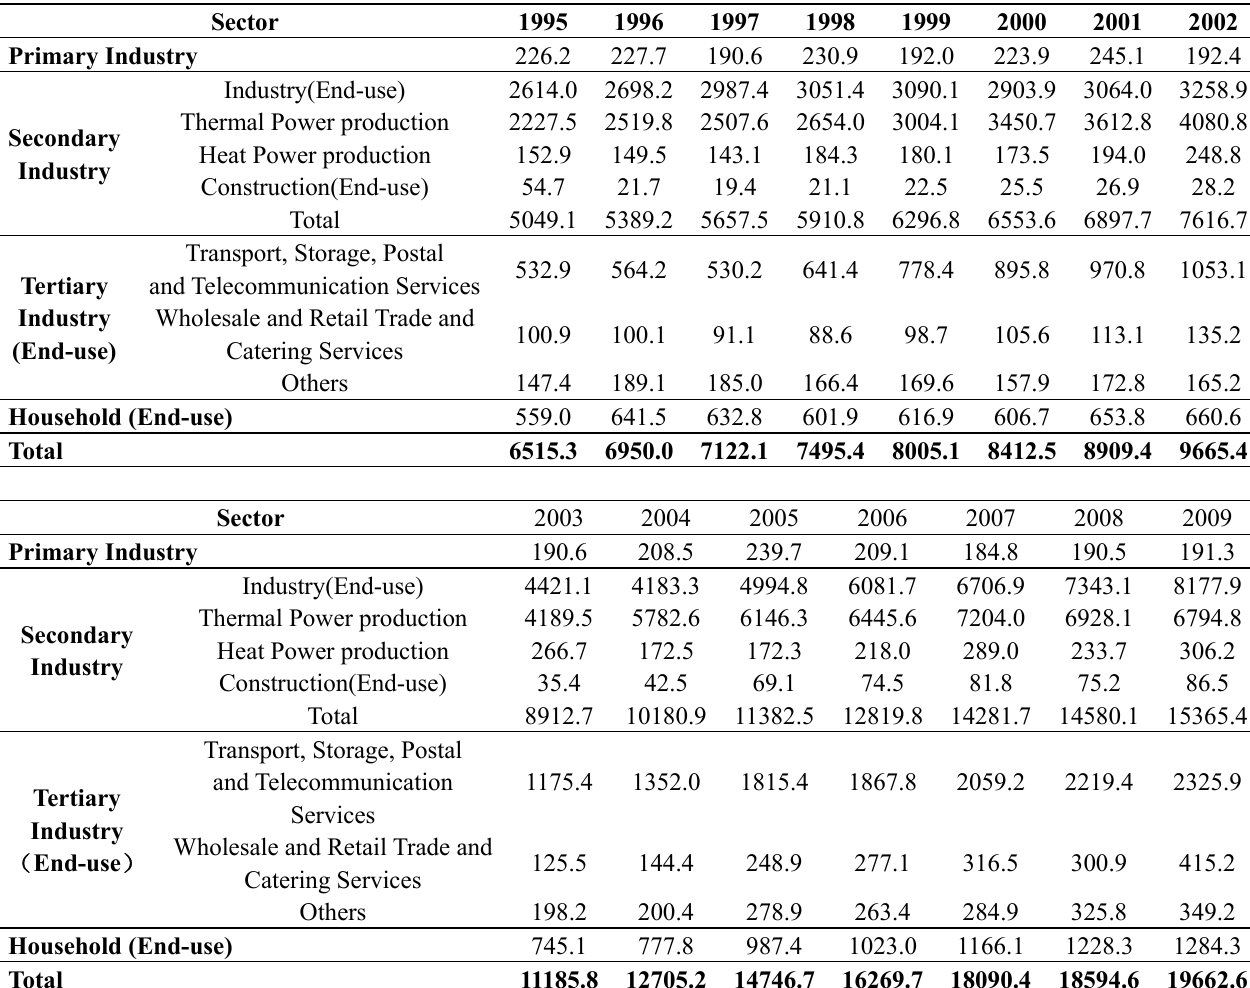
Table A2. Energy consumption by sectors (10 4 ton standard coal